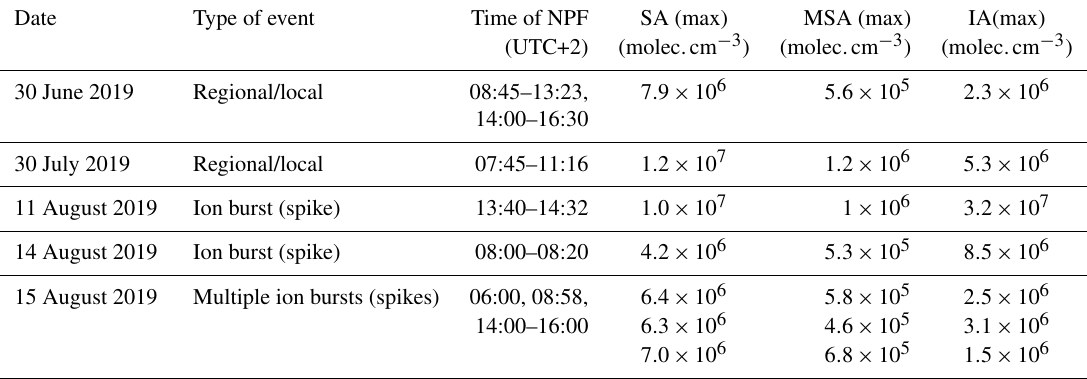
Table 1. Timing and maximum concentration of SA, MSA and IA during local and burst/spike nucleation events during the study